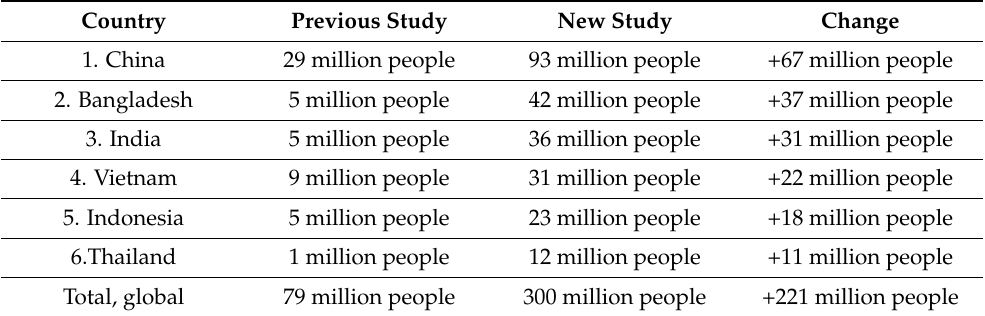
Table 9. A new study estimates that the number of people affected by rising sea levels has almost tripled (Adopted by Gupta, 2019; CGTN’s)